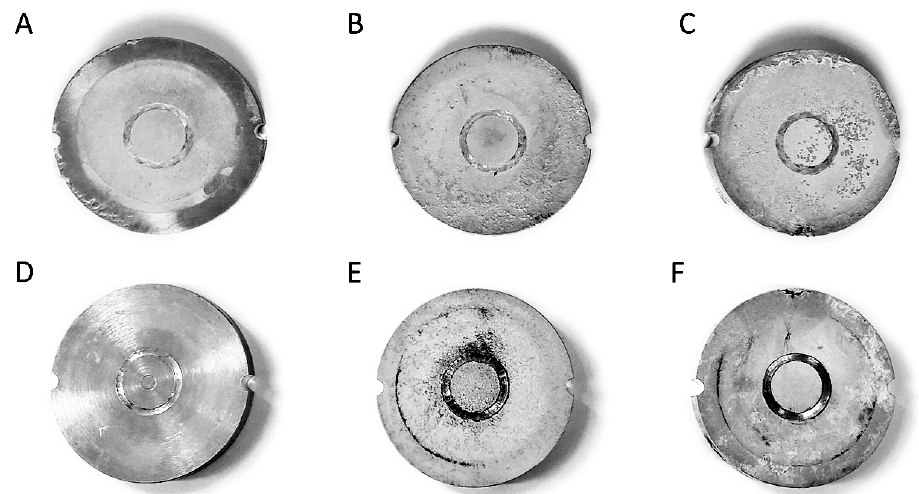
Figure 8. Surface of the samples after tribocorrosion test ( A ) untreated; ( B ) PEO-Si; and ( C ) PEO-P; and standard wear tests ( D ) untreated; ( E ) PEO-Si; and ( F ) PEO-P. Considering the samples after the tribocorrosion test, the presence of corrosion products on the surface of the untreated sample was observed (Figure 8A) and the coating resulted have greater adherence in the PEO-Si sample than in the PEO-P sample (Figure 8B,C). After the standard wear test, no significant differences were evident on the surface of the two PEO-treated samples from macroscopic observation (Figure 8E,F) and the surface of the untreated sample (Figure 8D) was bright with the presence of the wear track, visible also on the PEO-treated sample. To better analyze the conditions of the coatings after the dry and the tribocorrosion tests, a more detailed analysis at the interface between the wear track and the coating was performed. The results of the stereo-microscope